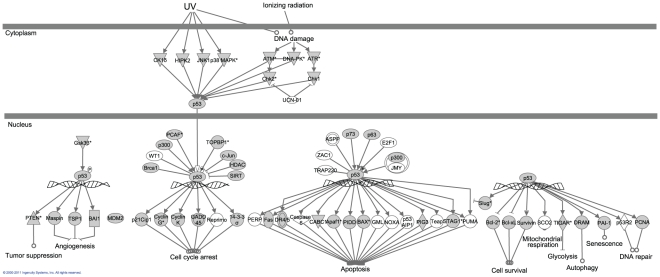
Genes involved in the various p53 mediated responses to DNA damage.Specific pathway details are likely to differ somewhat in the Cnidaria, but the presence of these components in A. palmata suggested the capacity for similar responses in corals. Filled symbols indicate proteins with homologs that were detected in the A. palmata dataset. Unfilled symbols indicate proteins that were not detected in our data, but are present in model vertebrate pathways.